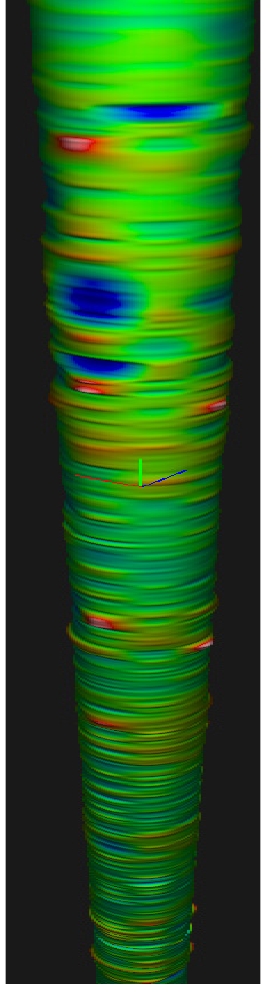
Figure 18. Well model based on real data.